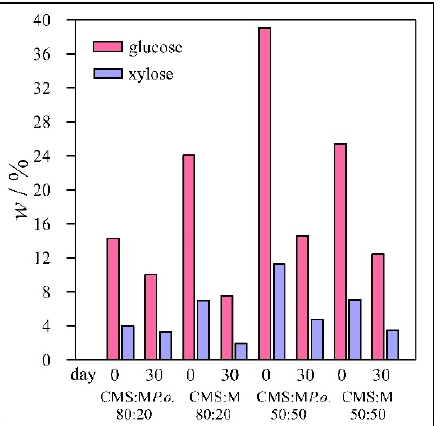
Figure 2. Concentrations of glucose and xylose in Miscanthus samples.